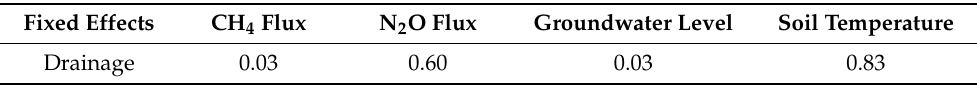
Table 2. p -values obtained from analysis of variance (ANOVA) of effects of drainage treatment